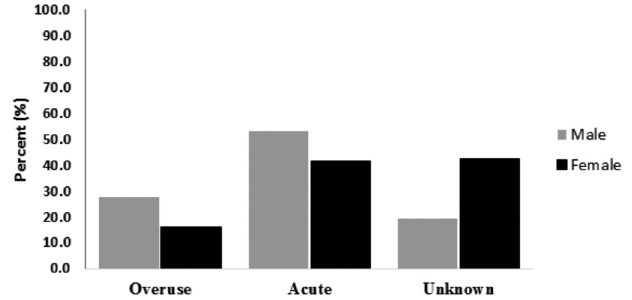
Figure 2. Injury types reported by handball players (male and female).